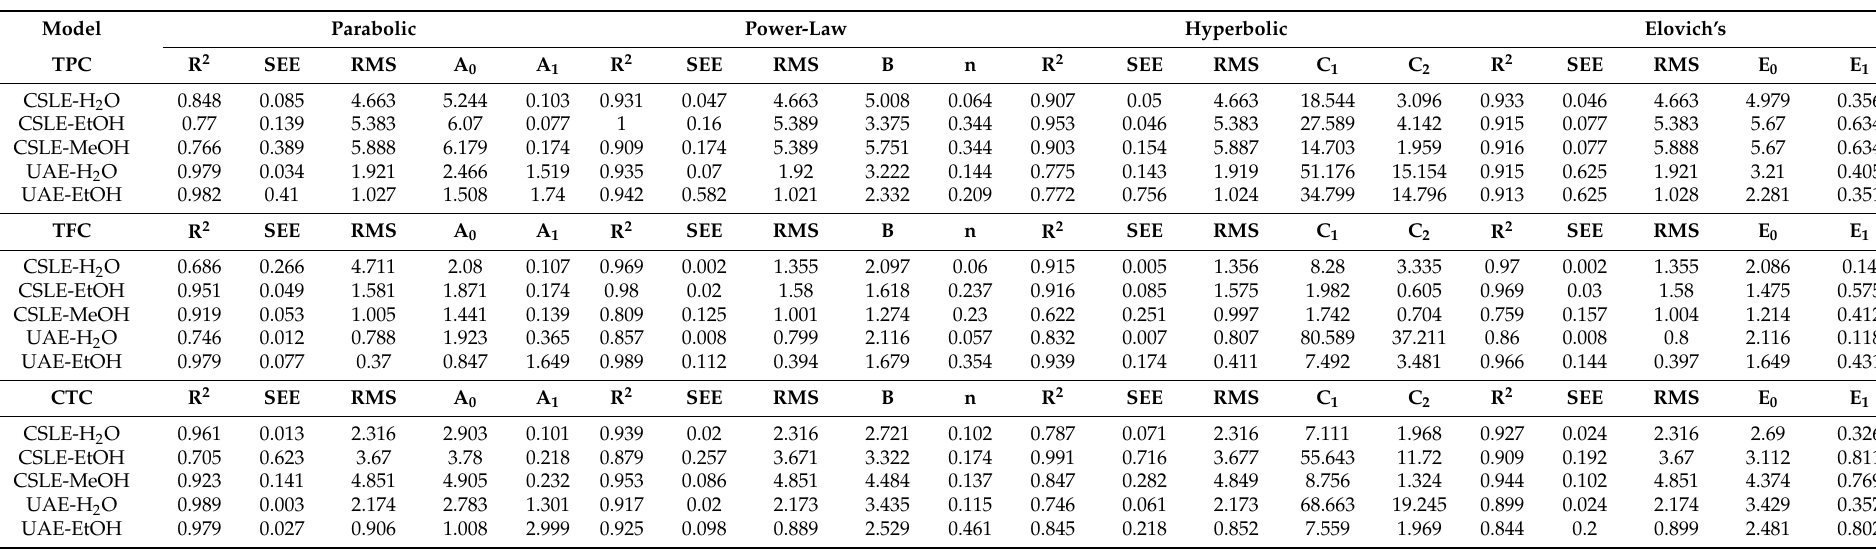
Table 2. Kinetic models, constants, and regressed statistical parameters for parabolic, power law, hyperbolic, and Elovich’s models for extraction of total phenolic compound (TPC) from lentil seed coat using conventional solid–liquid extraction (CSLE) and ultrasound-assisted extraction (UAE) using different solvents. Model